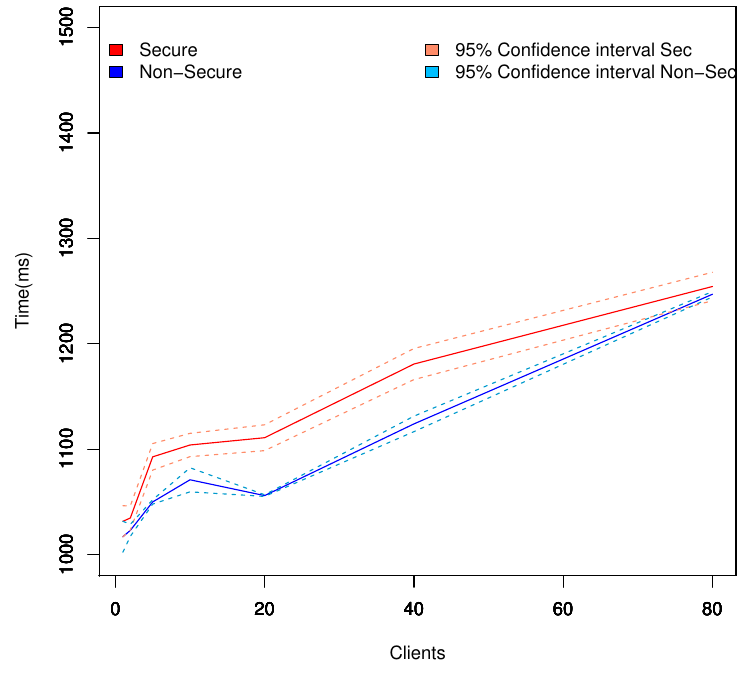
Figure 11. Response time with different numbers of user applications and the behaviour list of